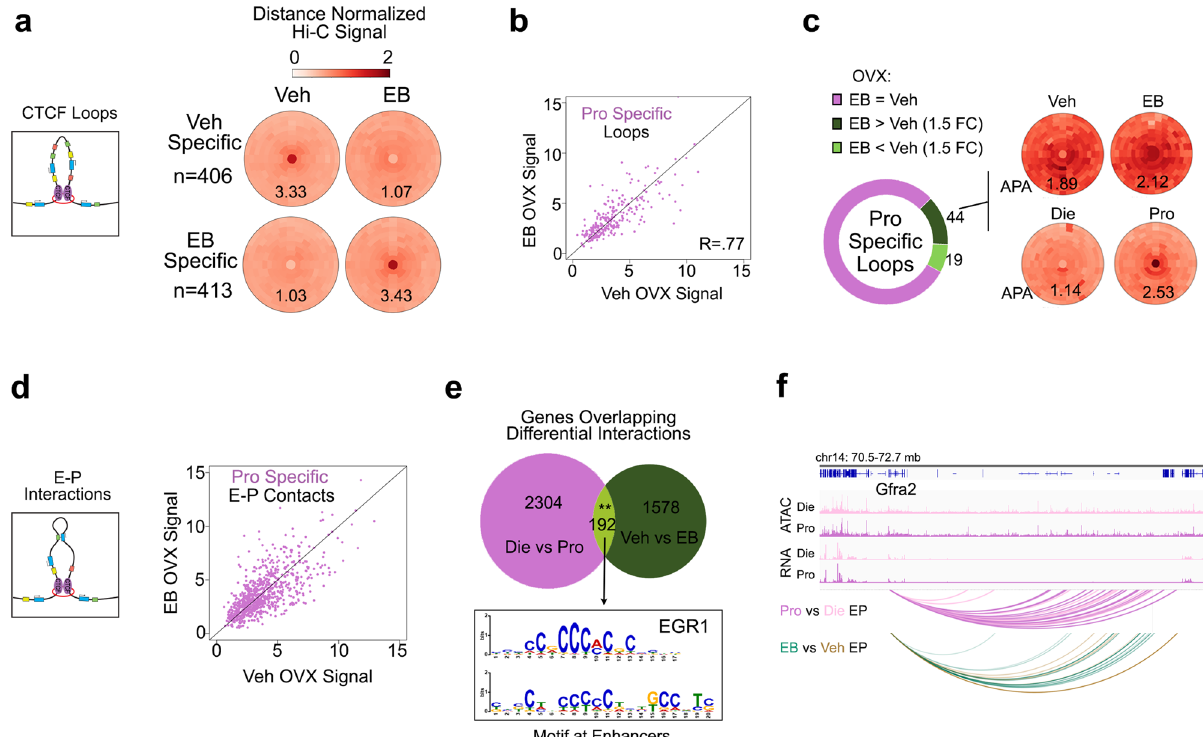
Fig. 7 Proestrus-like, oestradiol-induced changes in CTCF loops and E – P interactions in vHIP neurons of OVX animals. Acute oestradiol benzoate (EB) treatment induces changes in CTCF loops in OVX animals ( a ), which partially overlap with proestrus-speci fi c loops ( b ), and the majority of the overlapped loops are stronger in EB-treated animals ( c ). EB also changes E – P interactions that partially overlap with proestrus-speci fi c E – Ps ( d ). The gene overlap between differential E – P interactions across the cycle (Die vs. Pro) and after EB treatment in OVX mice (Veh vs. EB) is small but signi fi cant and shows an enrichment for Egr1 motifs at the enhancers (E value 6.0e − 4, e ). Example gene Gfra2 showing differential E – P interaction pro fi les across the oestrous cycle (Pro vs. Die; pooled three biological replicates/group) and after EB treatment (EB vs. Veh; pooled fi ve biological replicates/group) ( f ). IGV tracks show merged ATAC-seq and RNA-seq data for dioestrus (Die) and proestrus (Pro) derived from three biological replicates for each